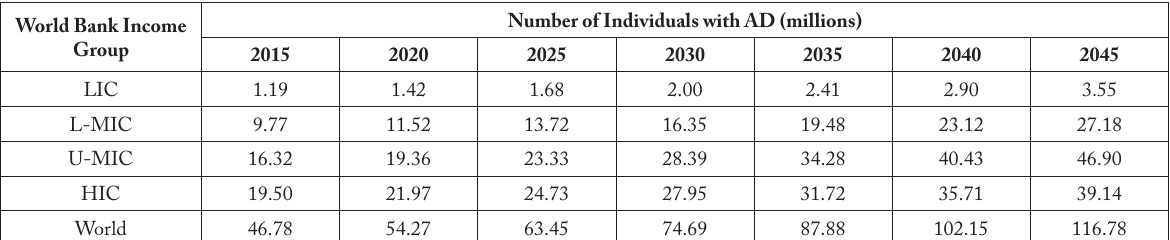
Number of Individuals with AD (millions)